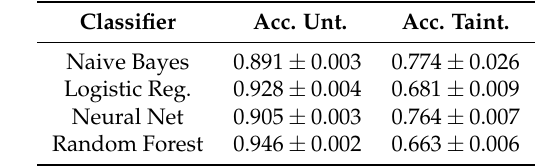
Table 1. Accuracy comparison (with precision) of four classifiers on clean (untainted) and attacked (tainted)